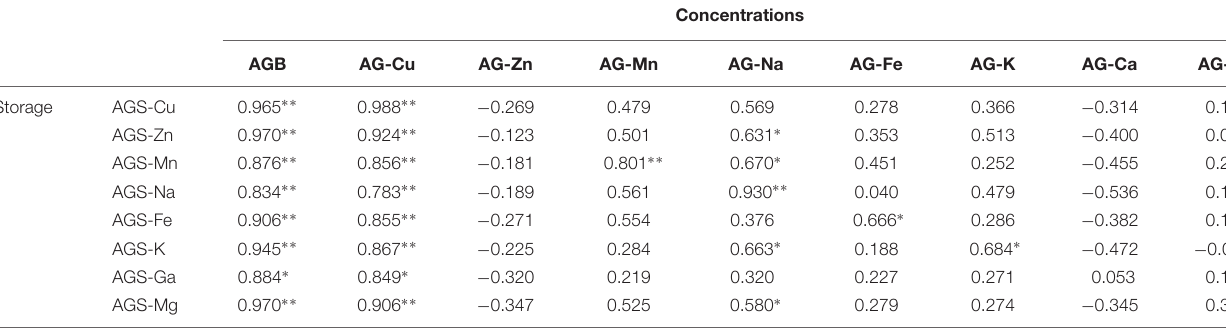
FIGURE 5 | Structural equation model results for the effects of N addition on macro- and micronutrient concentrations in (A) soil and (B) plant biomass of B. ischaemum . Numbers on arrows represent the standardized path coefficients (equivalent to correlation coefficients). Circles indicate error terms (e1–e5). Percentages close to endogenous variable. TABLE 3 | Correlation analysis between concentrations and storage in the plant aboveground tissues of B. ischaemum .